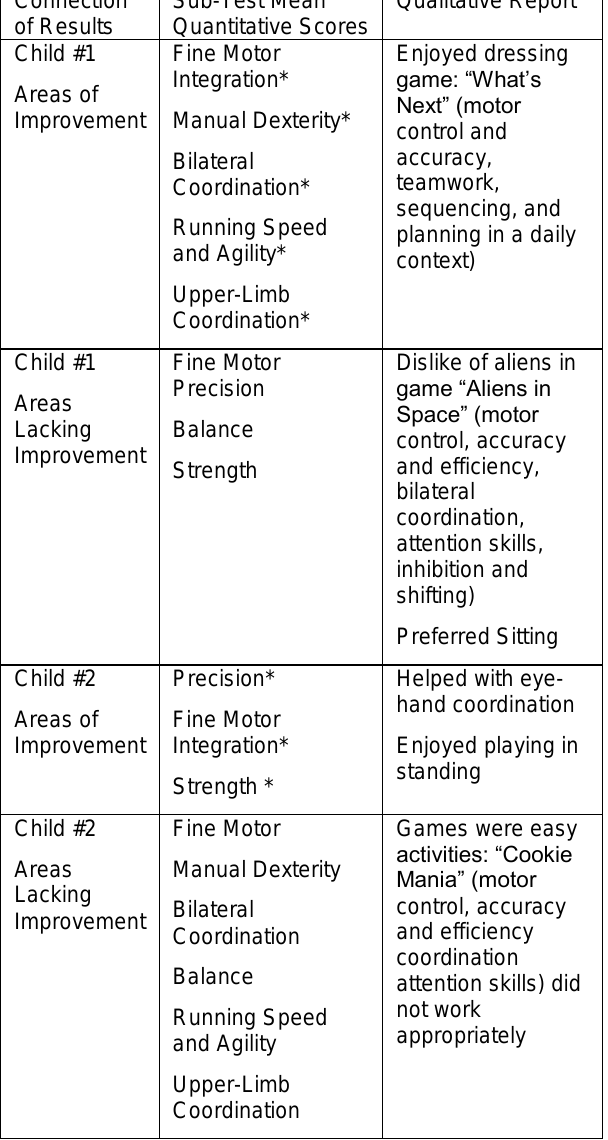
Table 4. Connection of Quantitative to Qualitative